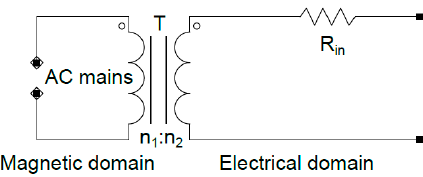
Figure 18. Equivalent circuit of a magnetic harvester with ideal impedance matching.